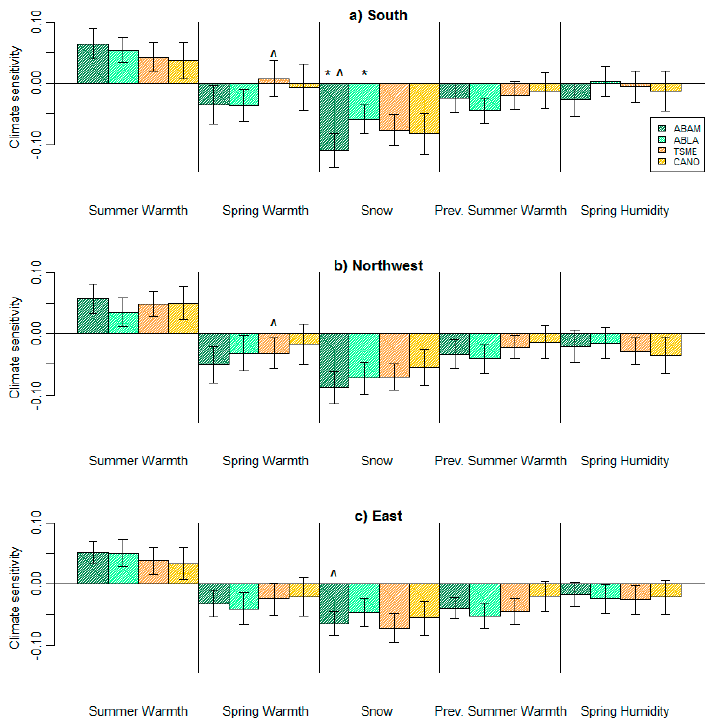
Figure 4. Climate sensitivity for all focal species across all three study sites at Mt. Rainier: ( a ) south side, ( b ) northwest side, ( c ) east side. The magnitude of climate sensitivity indicates the strength of sensitivity; the larger the bar, the more sensitive the group of trees is to that particular climate variable. A positive direction of climate sensitivity represents a positive growth response for an increase in the climate variable and vice versa. Error bars are 1.96× standard error. * s indicate significantly different climate sensitivities for two species at a site. ^ s indicate significantly different climate sensitivities for a single species across two sites. α = 0.05.